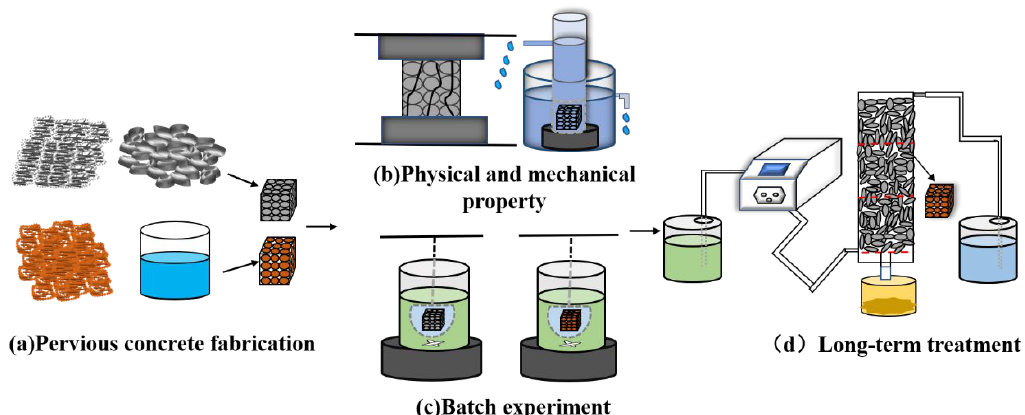
Figure 1. Experimental flow diagram.